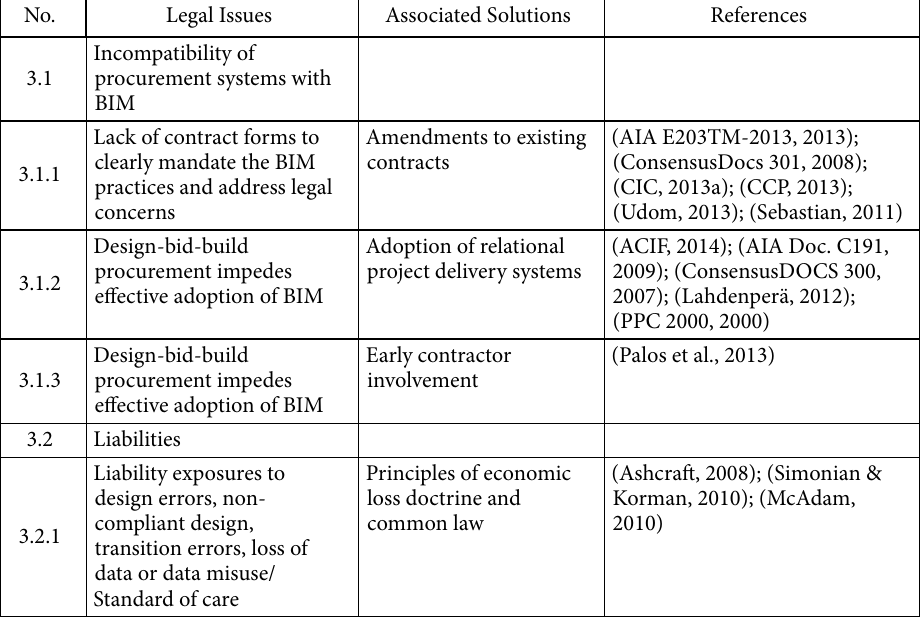
Table 2. Associated solutions to legal